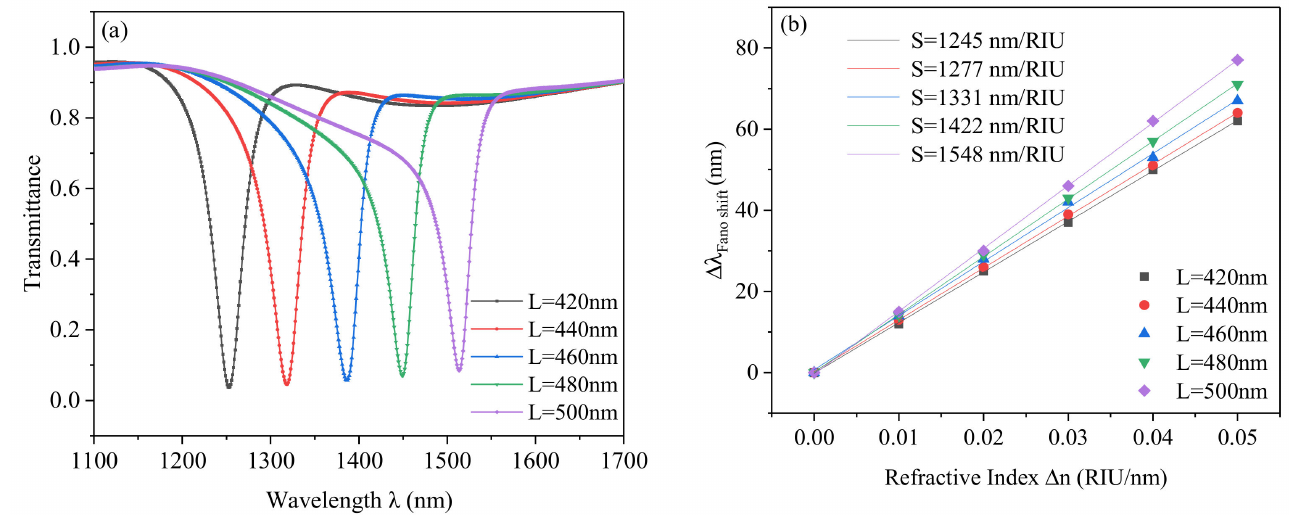
Figure 7. ( a ) Transmission spectra of the different length of the horizontal B-Type cavity L ; ( b ) linear fitting of the sensitivity. Furthermore, we analyze the influence of different h on the transmission